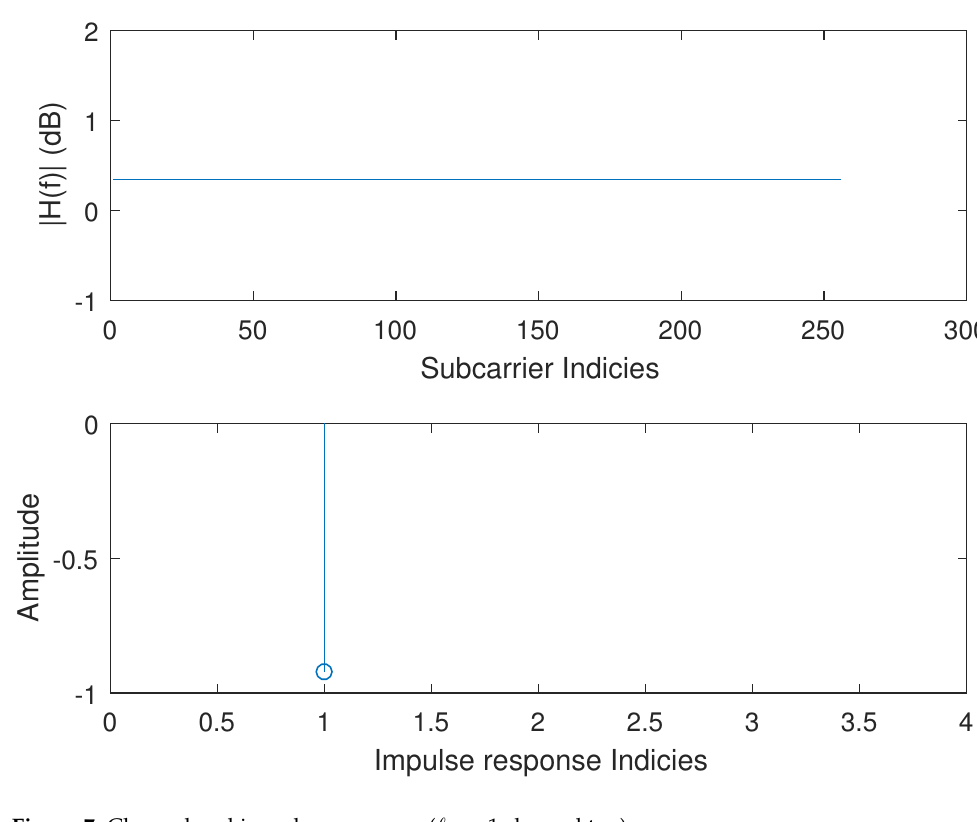
Figure 7. Channel and impulse responses ( (cid:96) h = 1 channel tap).